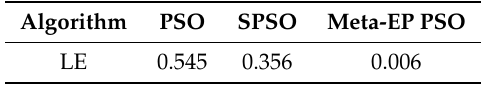
Figure 8. Position estimation in each iteration of the proposed meta-EP PSO algorithm. Table 4. Test results of different algorithms.